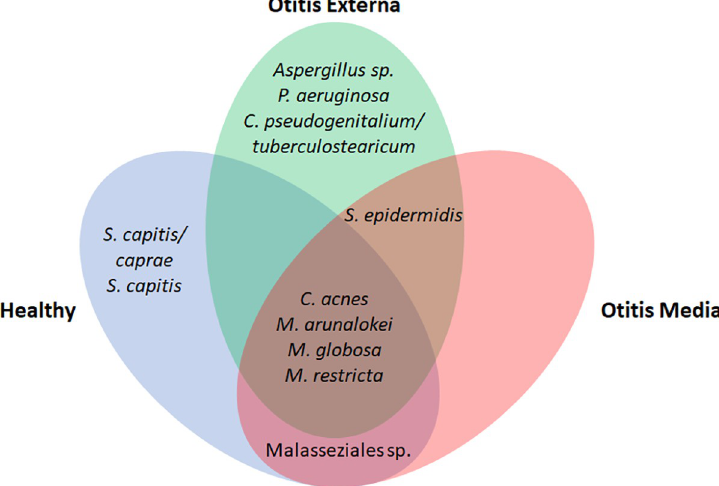
Fig 4. The panels show those species that were part of a shared core microbiome between all three study groups, shared between only two groups, or unique to a given